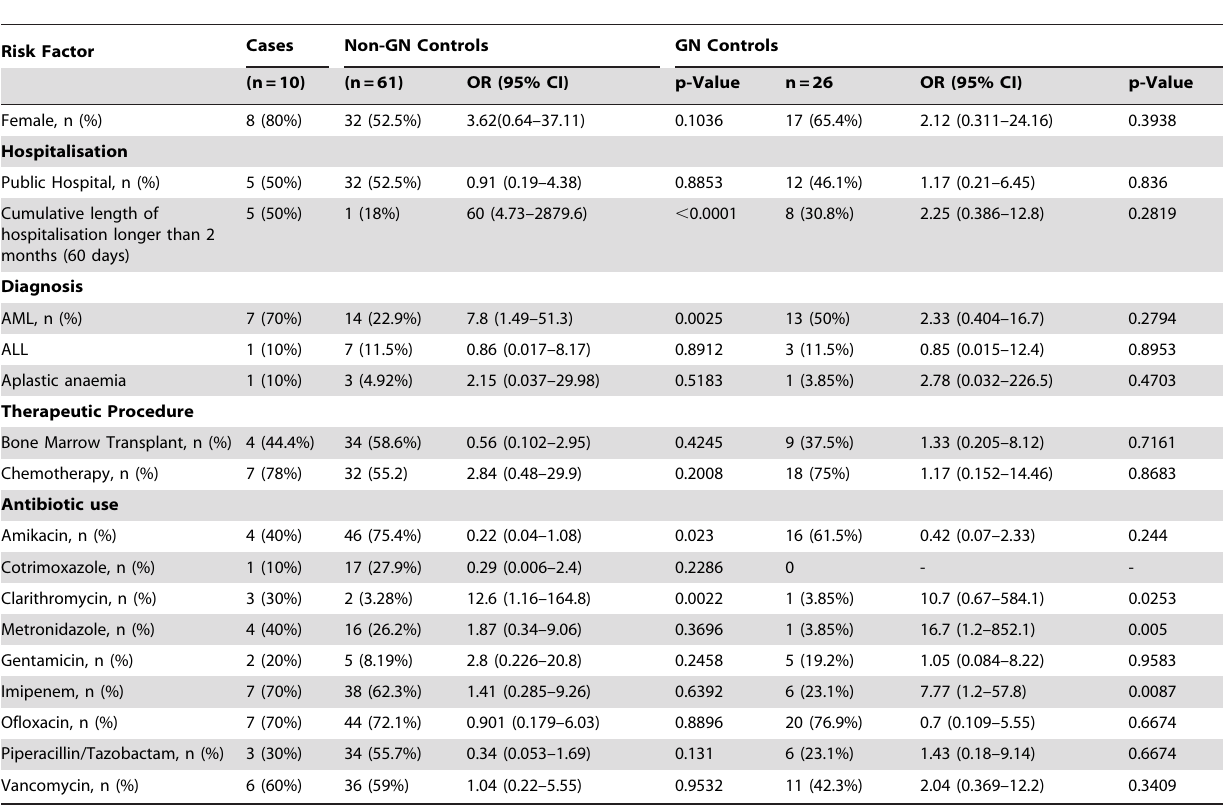
Table 3. Bivariate analysis of risk factors associated with multi-resistant Pseudomonas aeruginosa bloodstream infection